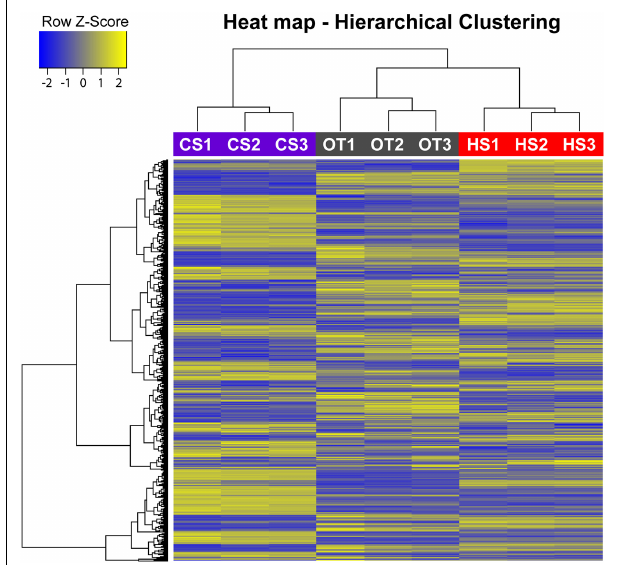
FIGURE 4 | Heat map of hierarchical clustering using the expression for 3,000 unigenes selected randomly (row; |log 2 fold change| ≥ 1, p < 0.05) in nine samples (columns). The expression levels of each unigene across samples are shown as their row Z-scores. CS, cold stress; OT, optimal temperature; HS, heat